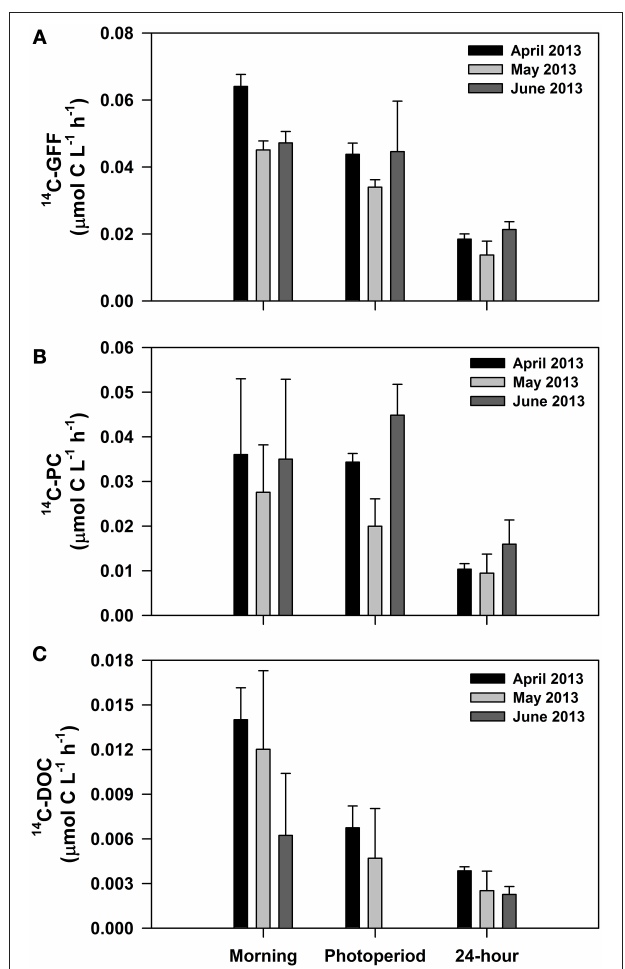
FIGURE 7 | Results from experiments conducted in April, May, and June 2013 examining daytime and nighttime changes in hourly rates of carbon fixation. Depicted are average hourly rates of (A) 14 C-GFF; (B) 14 C-PC; and (C) 14 C-DOC. All rates represent incubations initiated before dawn and terminated at different periods of the day (“morning” samples terminated at noon, “photoperiod” samples terminated at sunset, and “24-hour” samples terminated before dawn the following